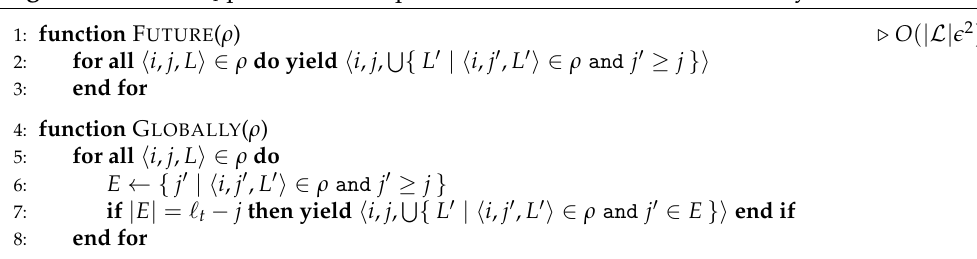
Algorithm 8 xt LTL f pseudocode implementation for Future and